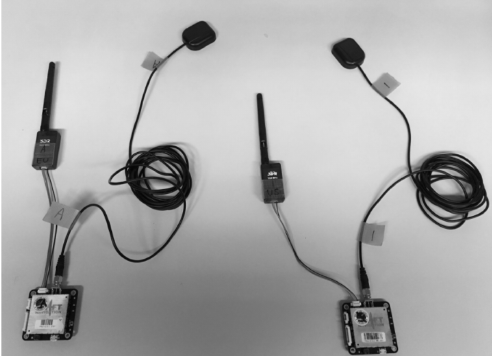
Figure 4. piksi is composed of two modules and record the rela- tive proposition of them